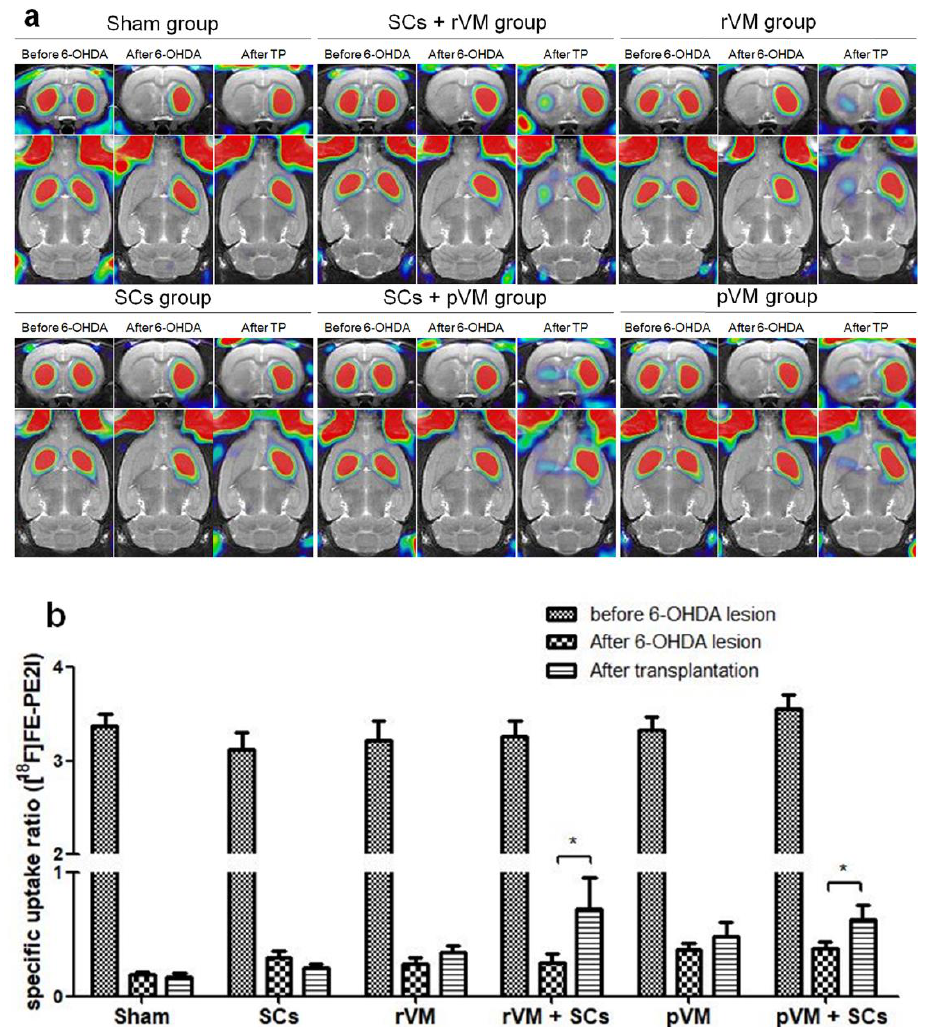
Figure 5. PET images of [ 18 F] FE-PE2I uptake distribution in rat brains. ( a ) Coronal (upper panel) and horizontal (lower panel) sections of each group were acquired 20 – 40 min after injection of [ 18 F]FE- PE2I. Left, middle, and right columns of each group represent [ 18 F]FE-PE2I uptake before the 6-OHDA lesion, after the 6-OHDA lesion, and after transplantation with different grafting materials, respectively. ( b ) SURs of [ 18 F] FE-PE2I in the grafted striatum at different time points and under different grafting conditions (* p < 0.05).